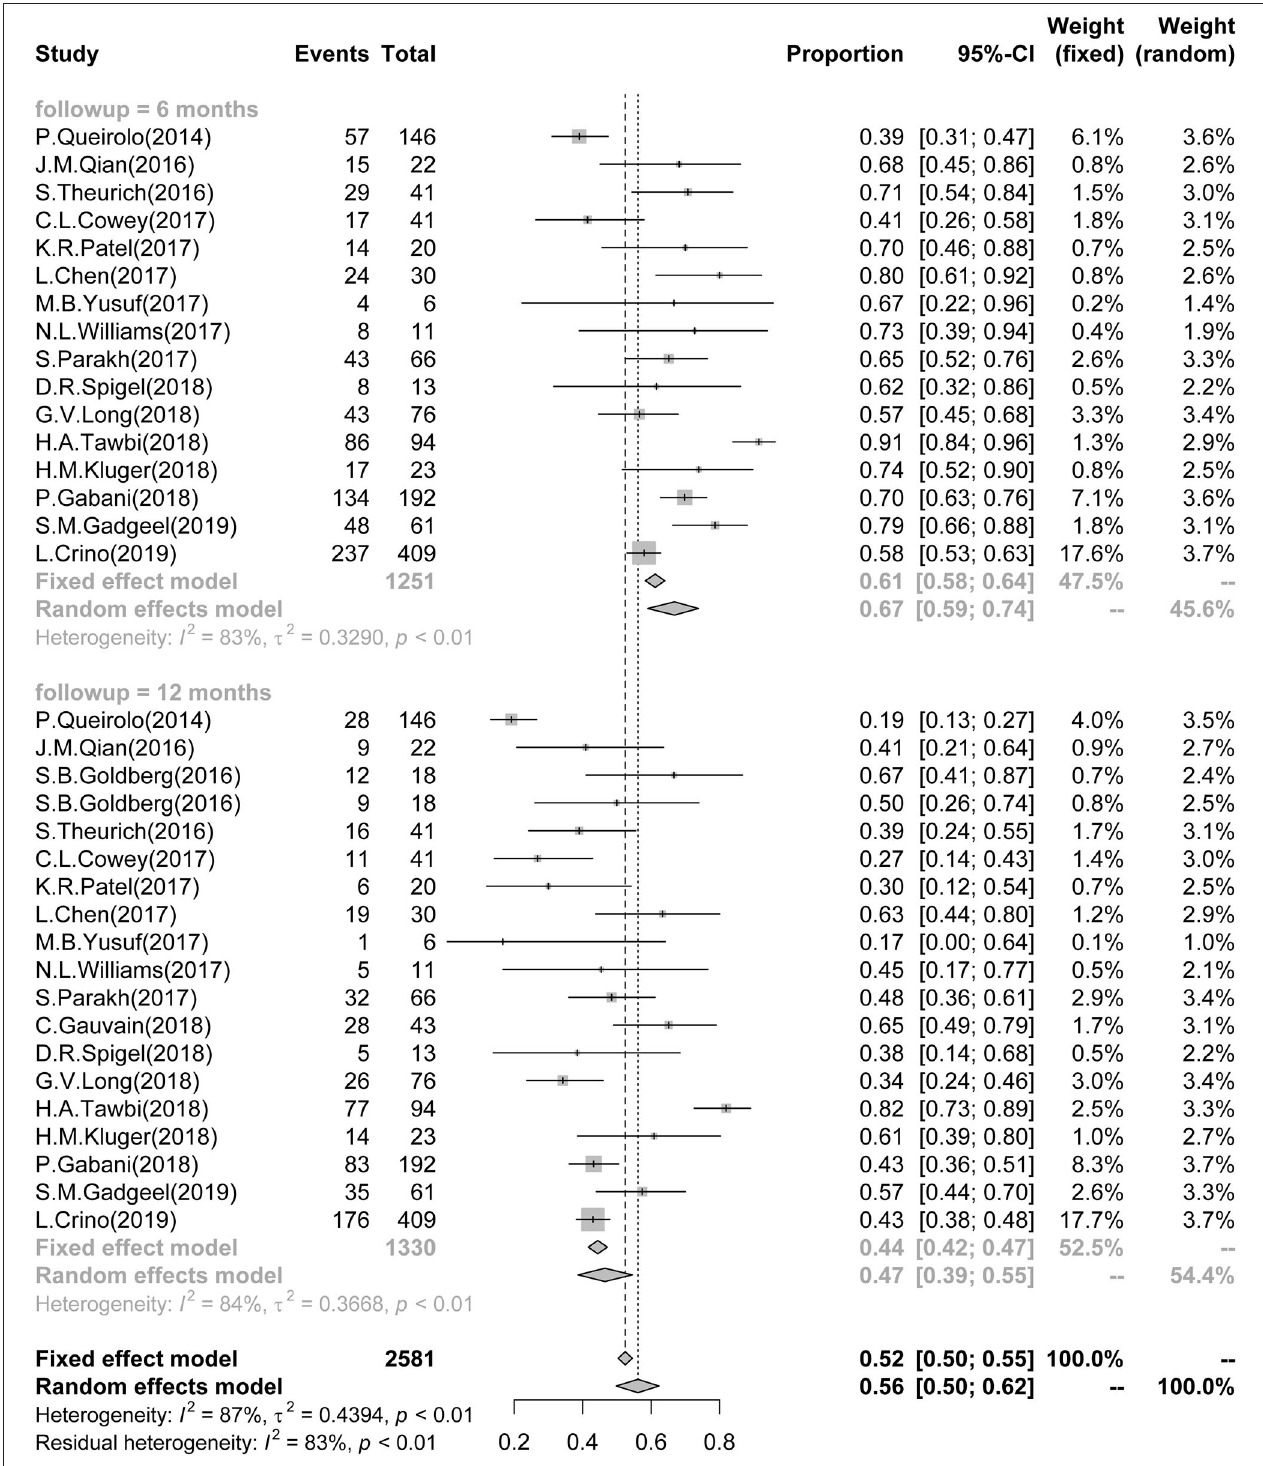
FIGURE 3 | Association between ICIs and Short-term Survival in BM patients. Forest plots showing 6- and 12-month survival rate in BM patients, treated with ICIs. ICI, immune checkpoint inhibitor; BM, brain metastasis.